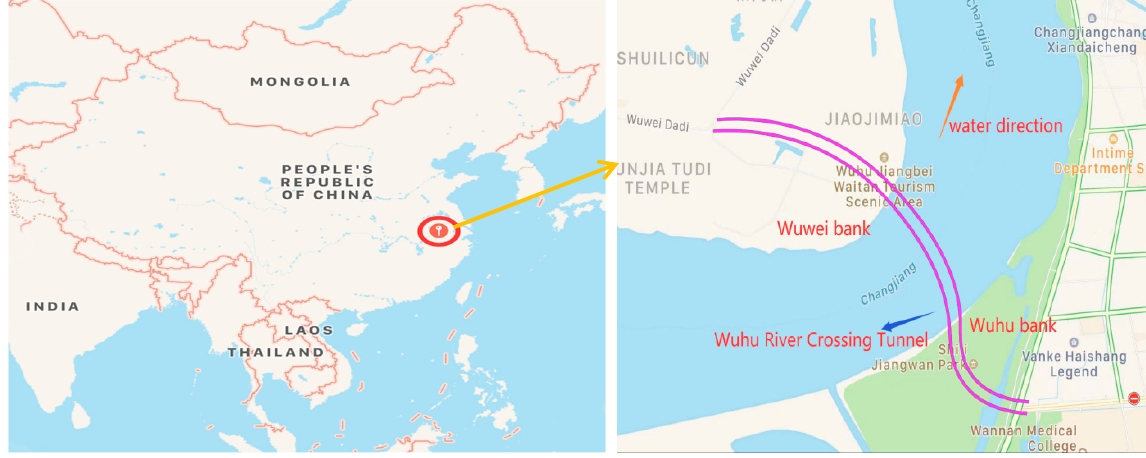
Figure 1. Position of Wuhu River-Crossing Tunnel.